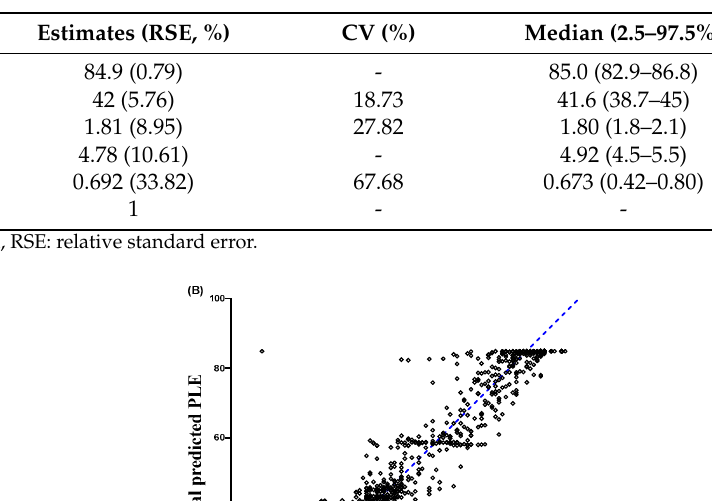
Table 2. The estimates pharmacodynamic parameters and median values (2.5–97.5%) of the final pharmacodynamic model.